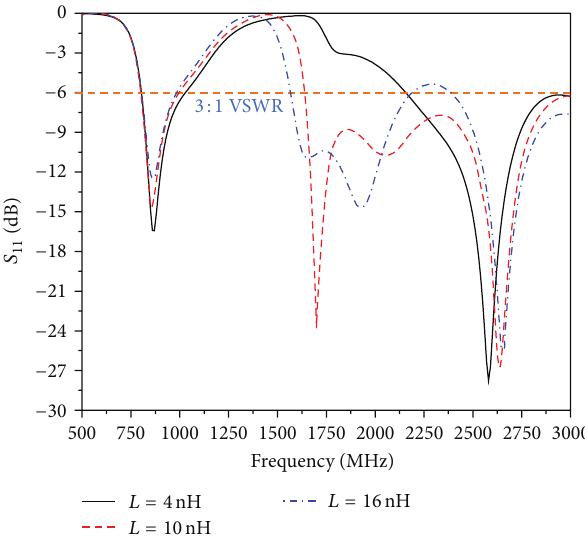
Figure 2: Simulated 𝑆 parameter as a function of 𝐿